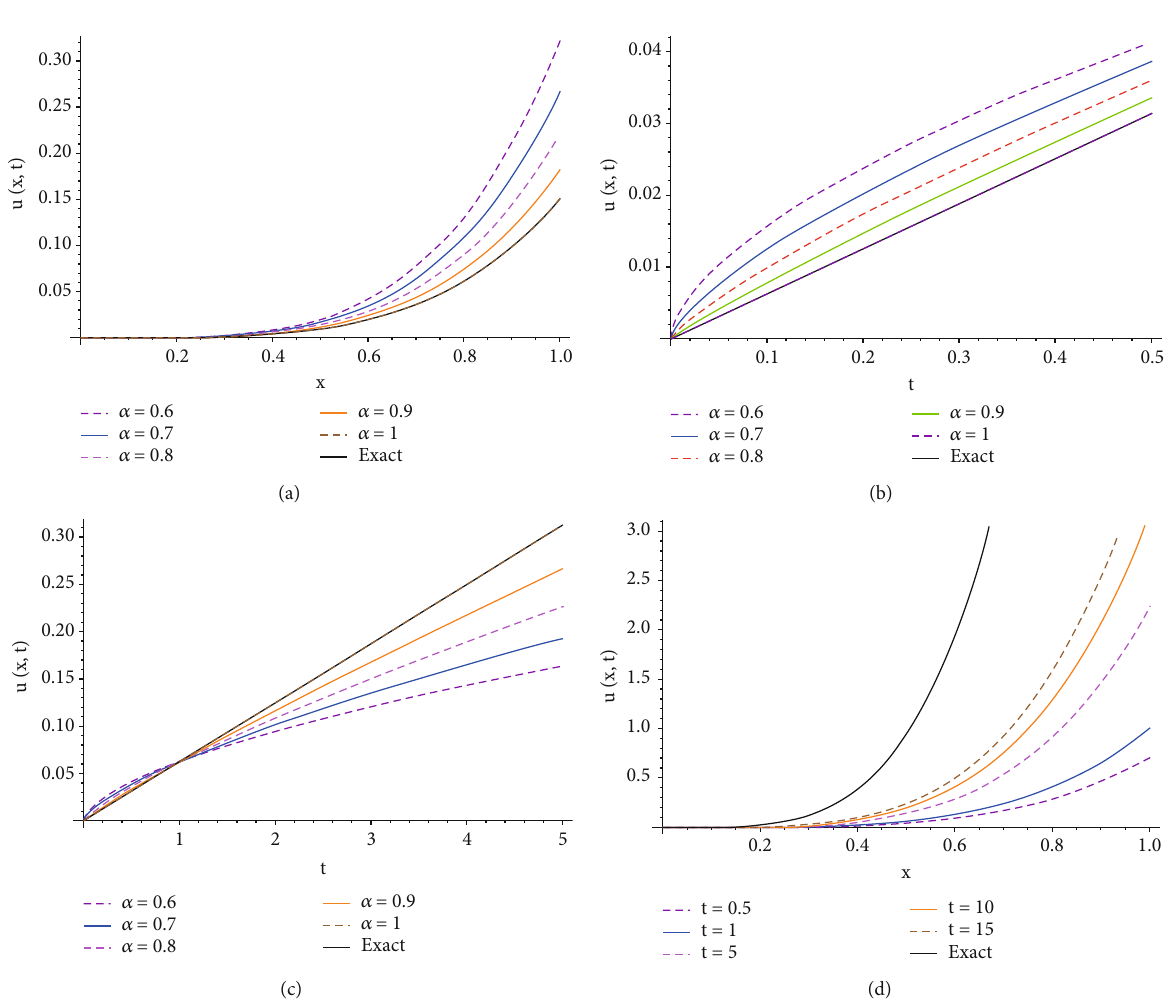
Figure 6: FRDTM solution pro fi le of Eq. (37): (a) u ð x , t Þ vs. x for di ff erent values α and t = 0 : 15 , (b) u ð x , t Þ vs. time t for di ff erent values α and x = 0 : 5 , (c) u ð x , t Þ vs. time t for di ff erent values α and x = 0 : 5 , and (d) u ð x , t Þ vs. x for di ff erent values t and α = 0 : 5 . Table 4: First-order approximate numerical solution by FRDTM of Eq. (37) at di ff erent values of α and comparison of absolute error at α = 0 : 9